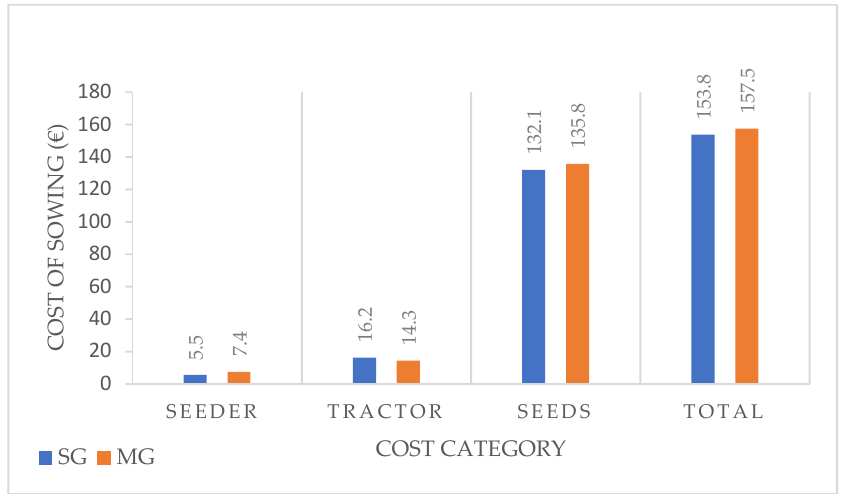
Figure 6. Sum of costs for sowing per hectare in semi-automatic guidance (SG) and manual guidance (MG).